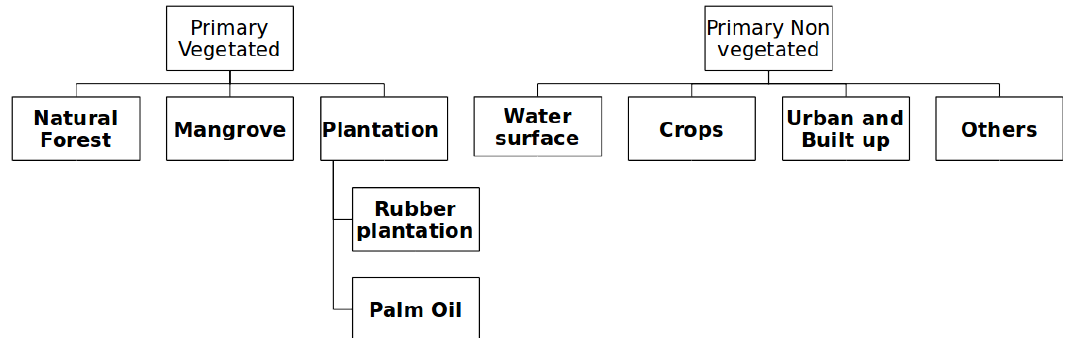
Figure 2. Typology was divided into primary vegetated and primary non vegetated classes. The primary vegetated classes include 4 different forest